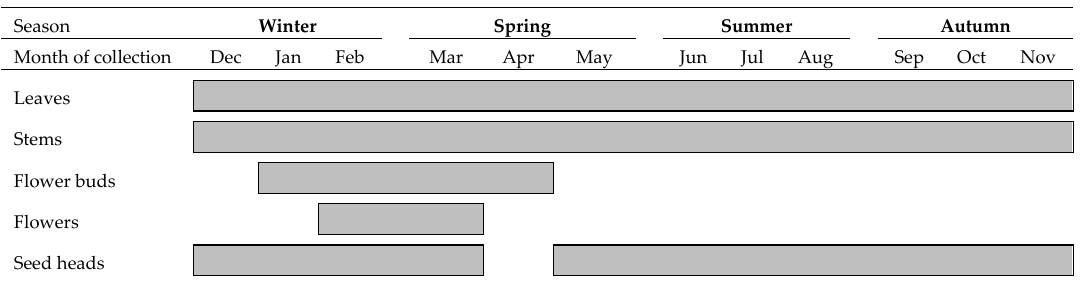
Figure 5. Environmental temperature and precipitation between December 2015 and November 2016.